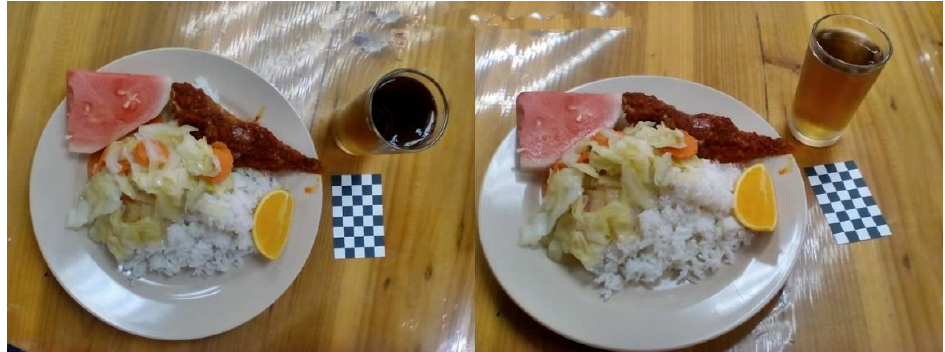
Figure 1. Sample image for Image PL, consisting six items which are the rice, fish, cooked vegetables, watermelon, orange and grass jelly drink. Image on the left was taken at approximately 90° angle and image on the right was taken at approximately 45° angle. Both images were taken in a lunch setting by a participant from a previous study [27].